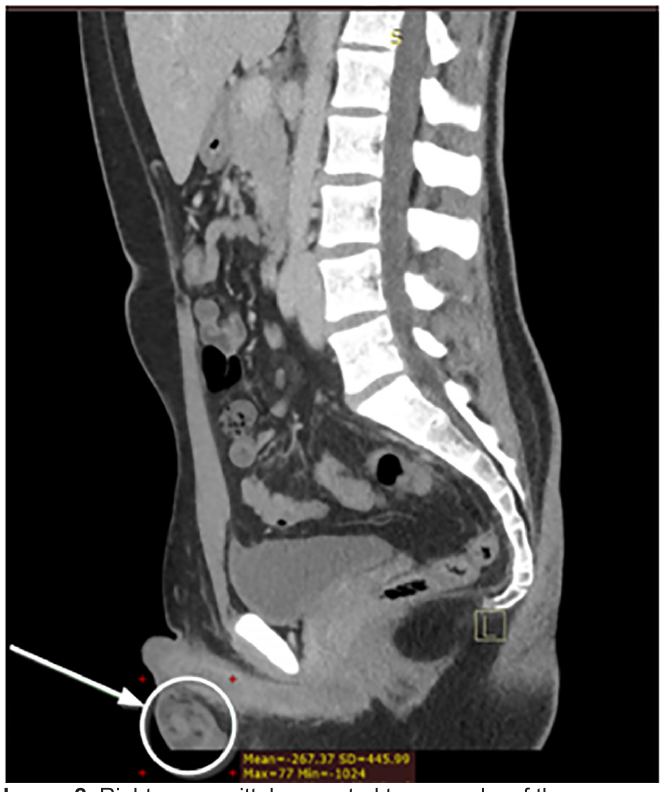
Image 2. Right parasagittal computed tomography of the abdomen and pelvis showing “whirl” sign consistent with testicular torsion in the right scrotum at the inferior periphery of the image. The white arrow and circle highlight this